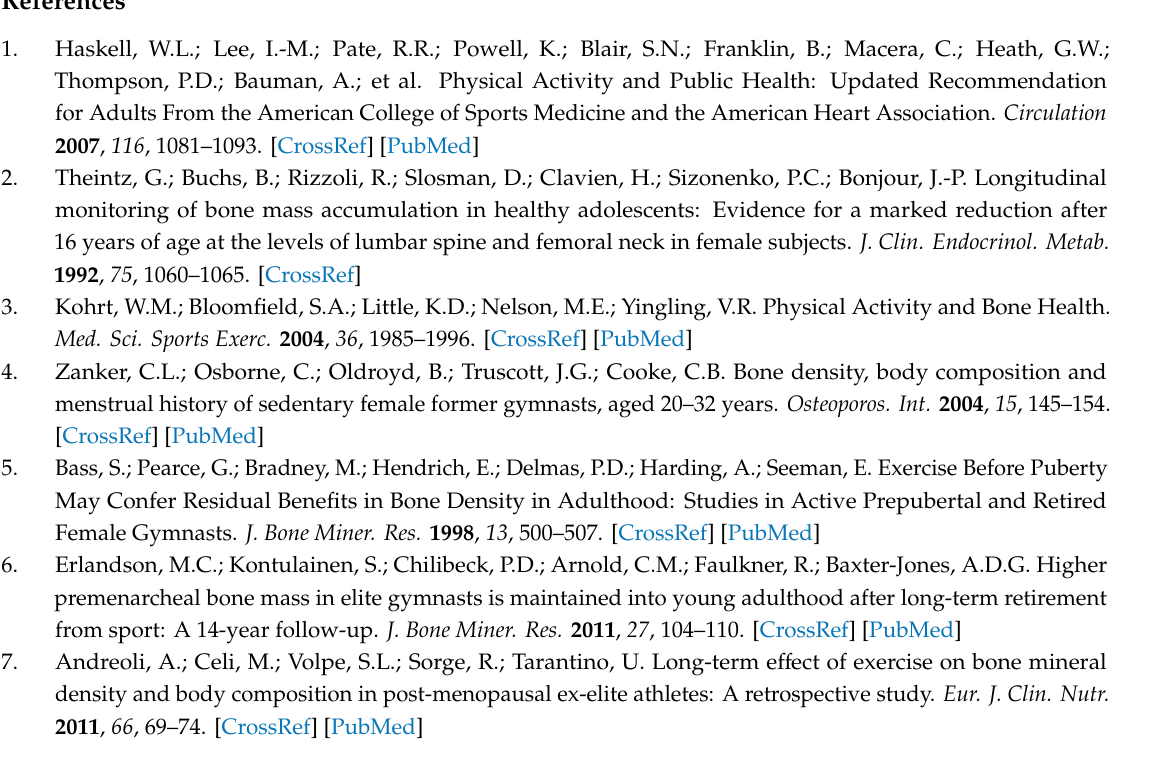
Figure S1: Proportions of the participants in di ff erent physical activity level groups across the age categories, Table S1: Age at menarche among participants ( n = 1081), Table S2: Proportion ( n ) of the participants reporting fractures, musculoskeletal disorders / symptoms, and anorexia nervosa diagnosis according to physical activity (PA) level at the age of 13–16, Table S3: Proportion ( n ) of the participants reporting fractures, musculoskeletal disorders / symptoms, and anorexia nervosa diagnosis according to age at menarche (AAM)